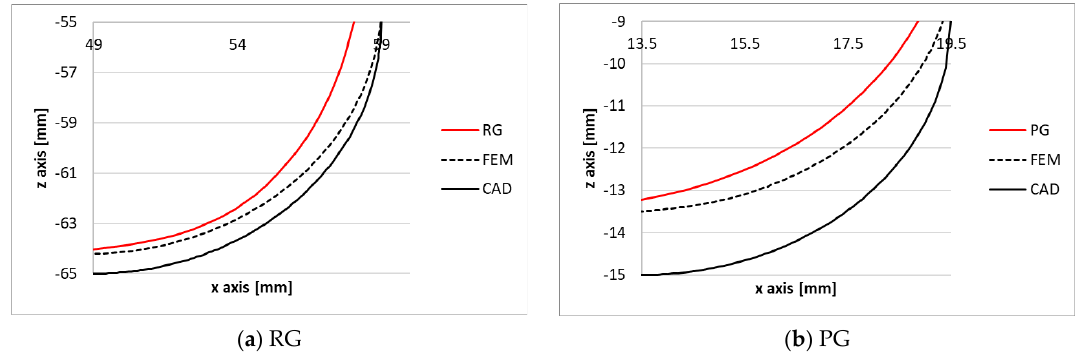
Figure 11. Comparison of cup LP between experimental (red), simulation (black dashed) and CAD (black). The FEM curves for the two punches lie between those of the CAD and experimental; this indicates a good ability to simulate the deep drawing process. After validation, sim- ulations were used to highlight the behaviour of punches during the deep drawing pro- cess. Figure 12a plots the punch load as a function of the stroke. It can be seen that both